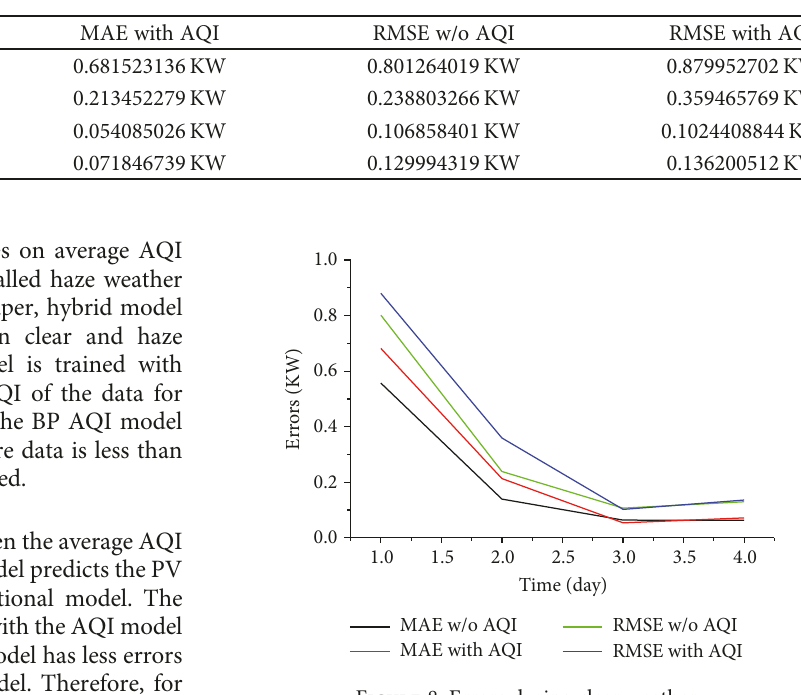
Table 3: Errors in KW during clear weather.